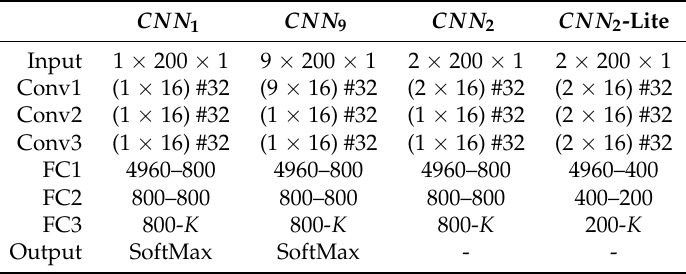
Table 1. Configuration list of selected models working on the India Pines dataset for the illustration of input and output modifications. FC, fully-connected.